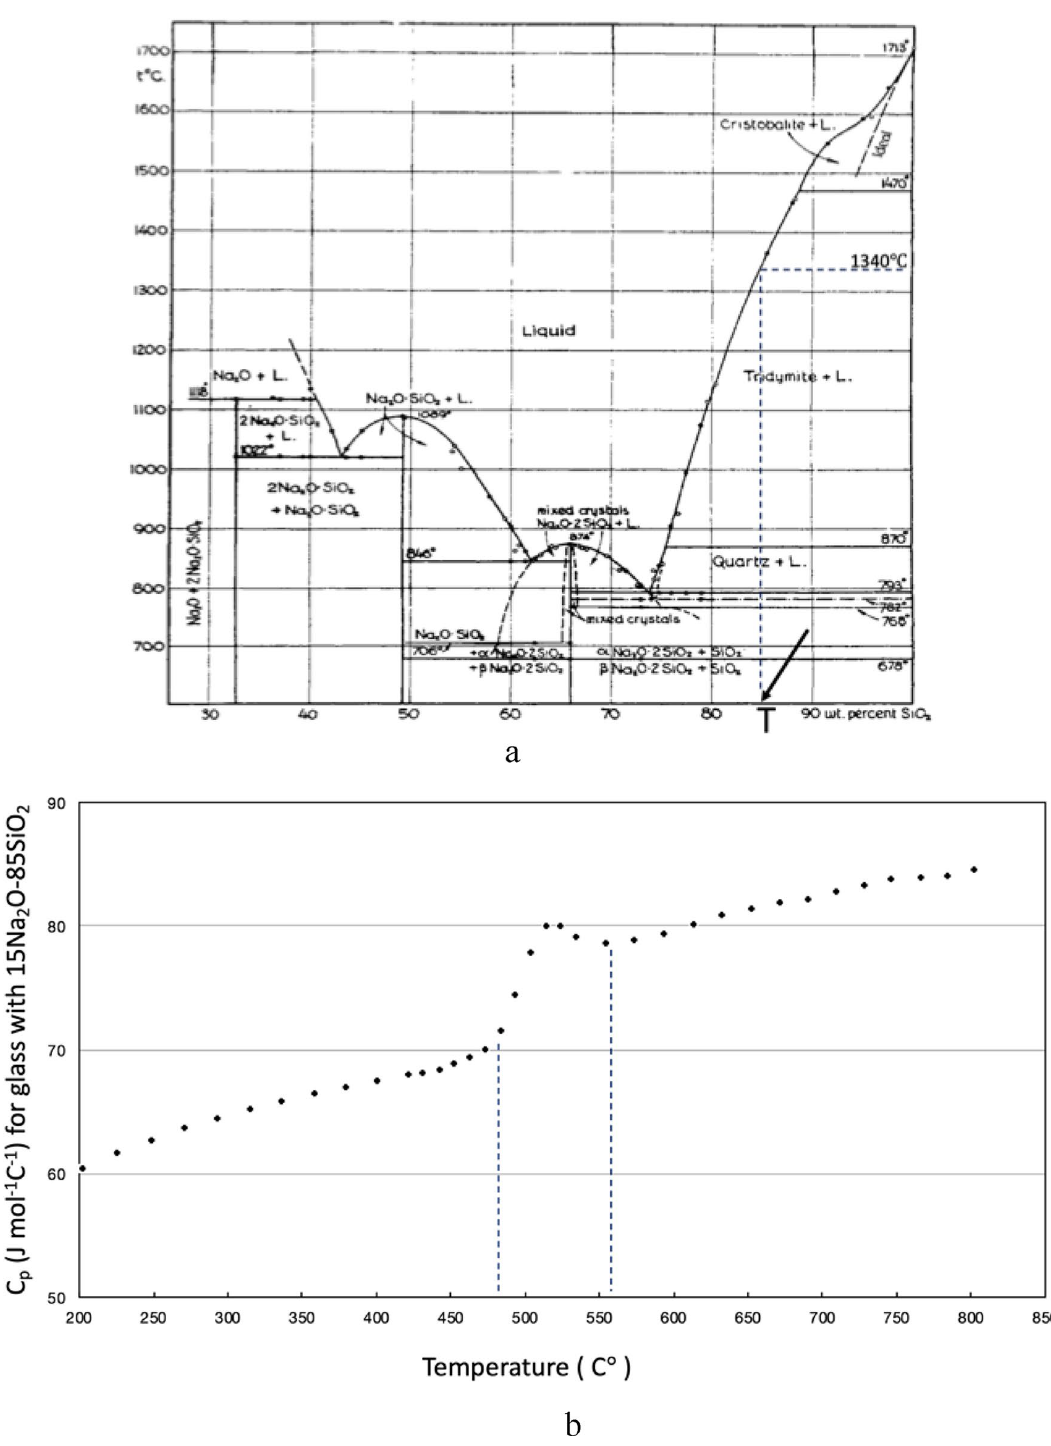
Figure 3. ( a ) The Na 2 O-SiO 2 phase diagram. Point T, indicated by an arrow, represents sodium silicate glass with 15 wt.% of NaO 2 . For this particular glass, its liquidus temperature and critical temperature are found from the figure to be 1340 and 870 °C, respectively. Reproduced from Ref. 16 . ( b ) The heat capacity Cp of sodium silicate glass with 15 mol.% of NaO 2 as a function of temperature. The data are taken from references 19,20 . The sharp rising of Cp between 480 and 560 °C in the figure indicates that heat absorption increases sharply in this temperature